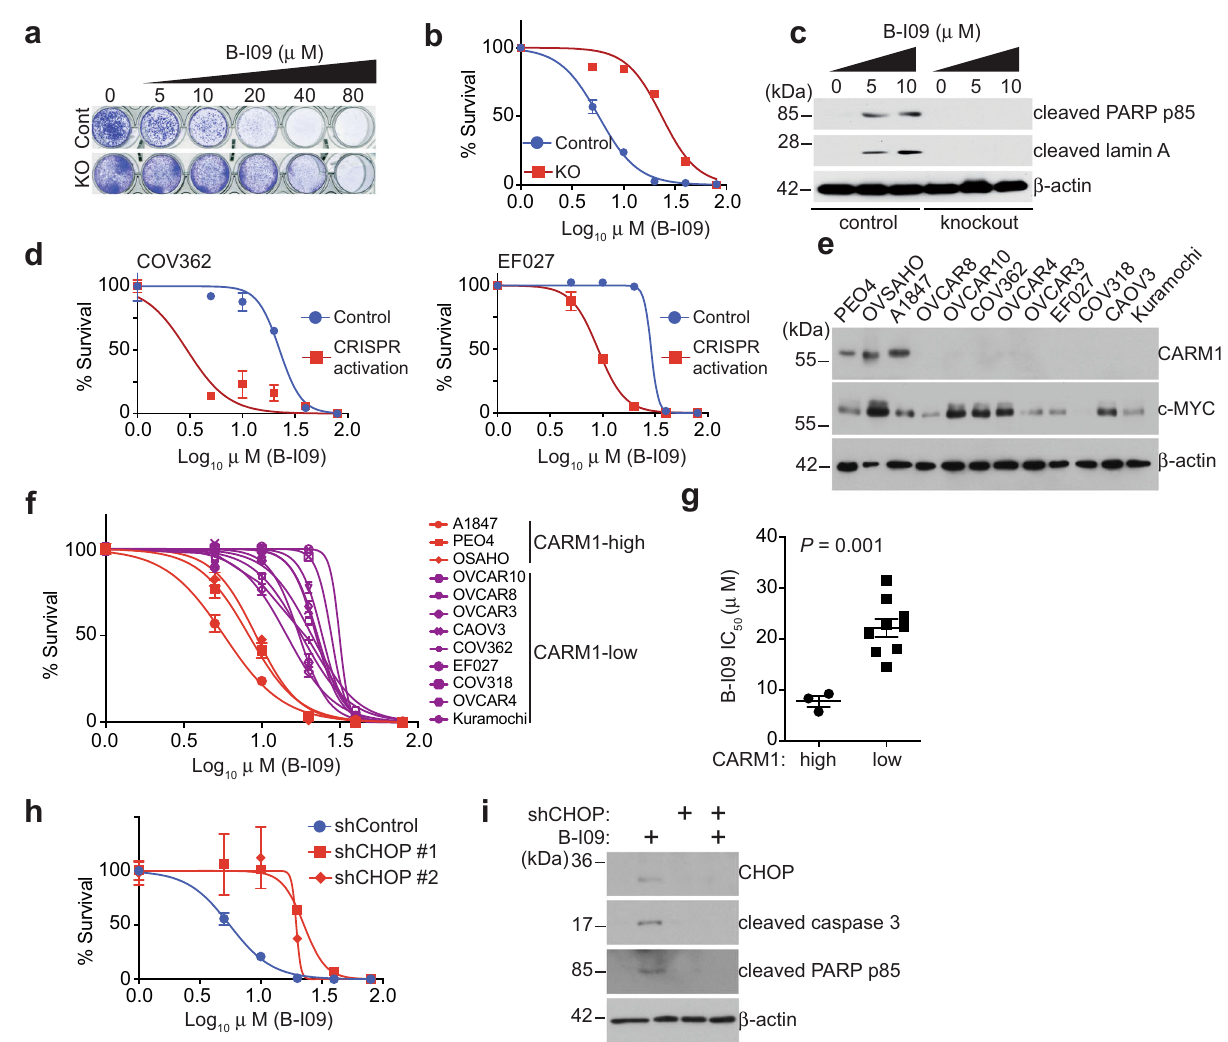
Fig. 5 CARM1 status correlates with response to inhibition of the IRE1 α /XBP1s pathway. a Representative images of colonies formed by control and CARM1 knockout A1847 cells treated with or without IRE1 α inhibitor B-I09 at the indicated concentrations. b B-I09 dose-responsive curves based on the colony-formation assay for control and CARM1 knockout A1847 cells. c Expression of apoptotic markers cleaved PARP and cleaved Lamin A and a loading control β -actin in control and CARM1 knockout A1847 cells treated with or without B-I09 at the indicated concentrations determined by immunoblot. Immunoblots are representative of three biologically independent experiments with similar results. d B-I09 dose-responsive curves based on colony- formation assay of the indicated control and CRISPR-mediated activation of endogenous CARM1-expressing COV362 and EF027 cells. e Expression of CARM1, c-MYC, and a loading control β -actin in a panel of the indicated cell lines determined by immunoblot. Immunoblots are representative of two biologically independent experiments with similar results. f B-I09 dose-responsive curves based on colony-formation assay for the indicated cells. g B-I09 IC 50 of CARM1-high ( n = 3) and CARM1-low ( n = 9) cell lines. h B-I09 dose-responsive curves based on colony-formation assay of the indicated control and shCHOP-expressing A1847 cells. i Expression of apoptotic markers cleaved caspase 3, cleaved PARP p85, and a loading control β -actin in control and shCHOP-expressing (#1) A1847 cells treated with or without B-I09 (5 μ g/ml, 48 h). Immunoblots are representative of two biologically independent experiments with similar results. Data represent mean ± SEM, n = 4 biologically independent experiments unless otherwise stated. P values were calculated using two-tailed t